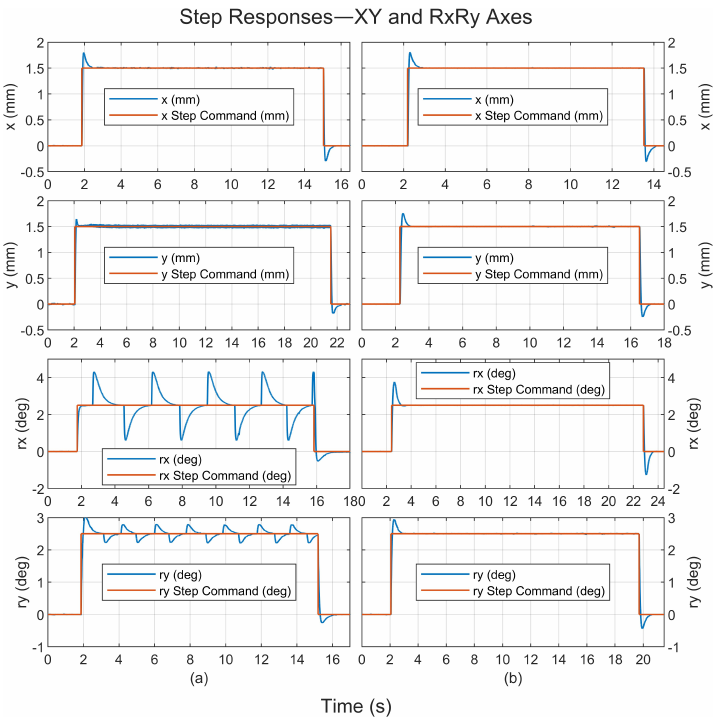
Figure 12. x – y and ψ – θ axes interpolation results: ( a ) step responses without linear interpolations; ( b ) step responses with 2-D linear interpolations.